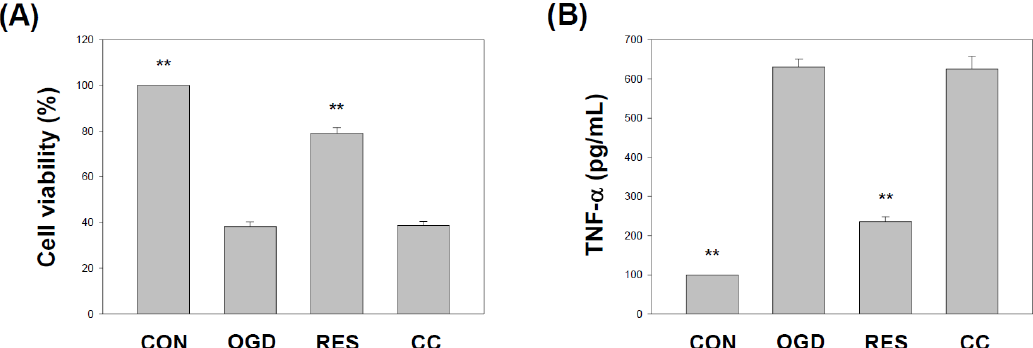
Figure 1. Resveratrol rescues OGD-mediated cell viability and TNF- α under the 3D scaffold. The cells were treated with OGD under the scaffold for 24 h and then treated with 10 µ M resveratrol (AMPK activator) or 10 µ M Compound C (AMPK antagonist) for another 48 h. The cell experiment under the scaffold was divided into four groups: (1) Control (CON) group represents cells with no treatment, cultured in a new medium for 72 h; (2) OGD group represents cells treated with OGD for 24 h, then exchanged with the new medium for another 48 h; (3) Resveratrol (RES) group, represents cells treated with OGD for 24 h, then exchanged the new medium with 10 μ M Resveratrol for an- other 48 h; and (4) Compound C (CC) group represents cells treated with OGD for 24 h, then treated then exchanged the new medium with 10 μ M Compound C and 10 μ M Resveratrol for another 48 h. ( A ) Cell viability was detected by an SRB assay. ( B ) The cell culture supernatant was harvested, and ELISA measured the secretion of TNF- α. Values are expressed as percentages of the indicated level in CON and are presented as the mean ± SEM values from three independent experiments. Specific comparison to the indicated SH-SY5Y cells with OGD ** p < 0.001 vs. cells with OGD. 2.2. Resveratrol Normalizes the Expression of IKK and NF- κB (p65) in OGD -Treated Cells on the 3D Scaffold OGD induces neuroinflammation in hippocampal neurons [76], PC12 cells [77], hu- man BE(2)M17 neuroblastoma cells [78], and increases NF- κB pathway signaling [79]. This results in increased transcription of downstream target genes [80], leading to increased levels of inflammatory chemokines and cytokines [81,82]. Therefore, we evaluated the lev- els of the IKKα, IKK β , and p65 transcripts in cells exposed to OGD. We found that the mRNA transcripts of IKKα, IKK β , and p65 were higher in the SH-SY5Y cells treated with OGD (Figures 2 and 3A). Treatment with resveratrol significantly normalized the expres- sion of IKKα, IKK β , and p65, but only in the absence of co-treatment with compound C (Figures 2 and 3A). In addition, the incubation of cells with OGD induced the transloca- tion of p65 protein into the nucleus (Figures 3B and S3A). Compared with the OGD treat- ment alone, co-treatment with resveratrol significantly normalized p65 nuclear expression in the cells, but these changes were not present in the presence of Compound C (Figures 3B and S3A).